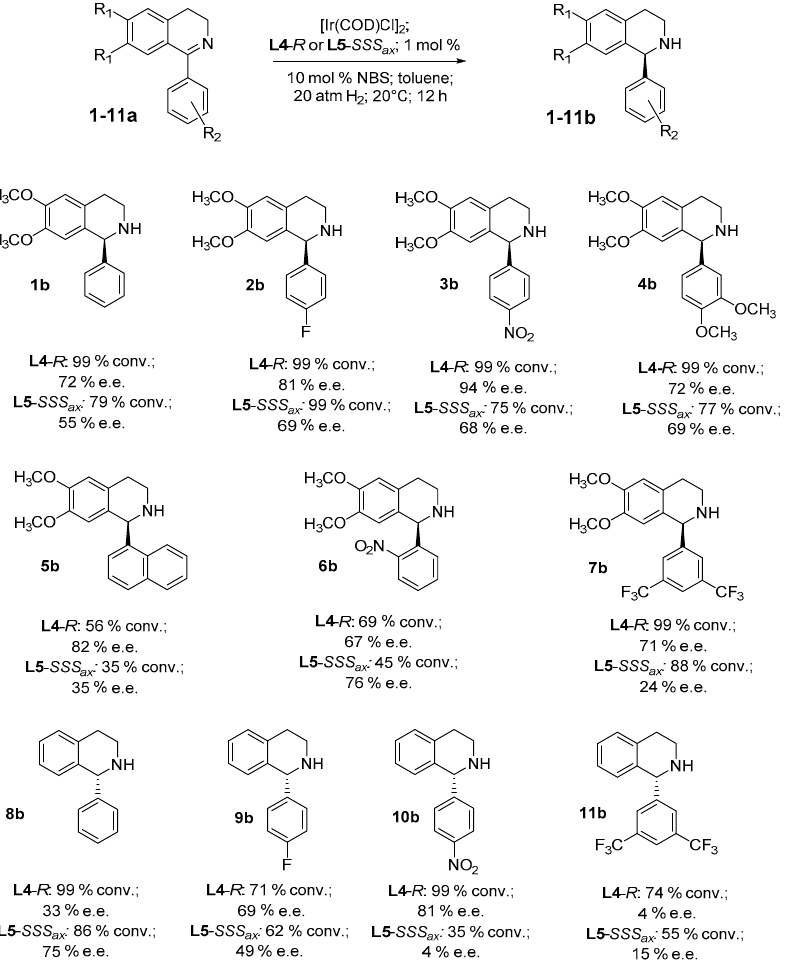
Figure 2. Asymmetric hydrogenation of di ff erent 1-aryl imines using L4 and L5 as ligands.